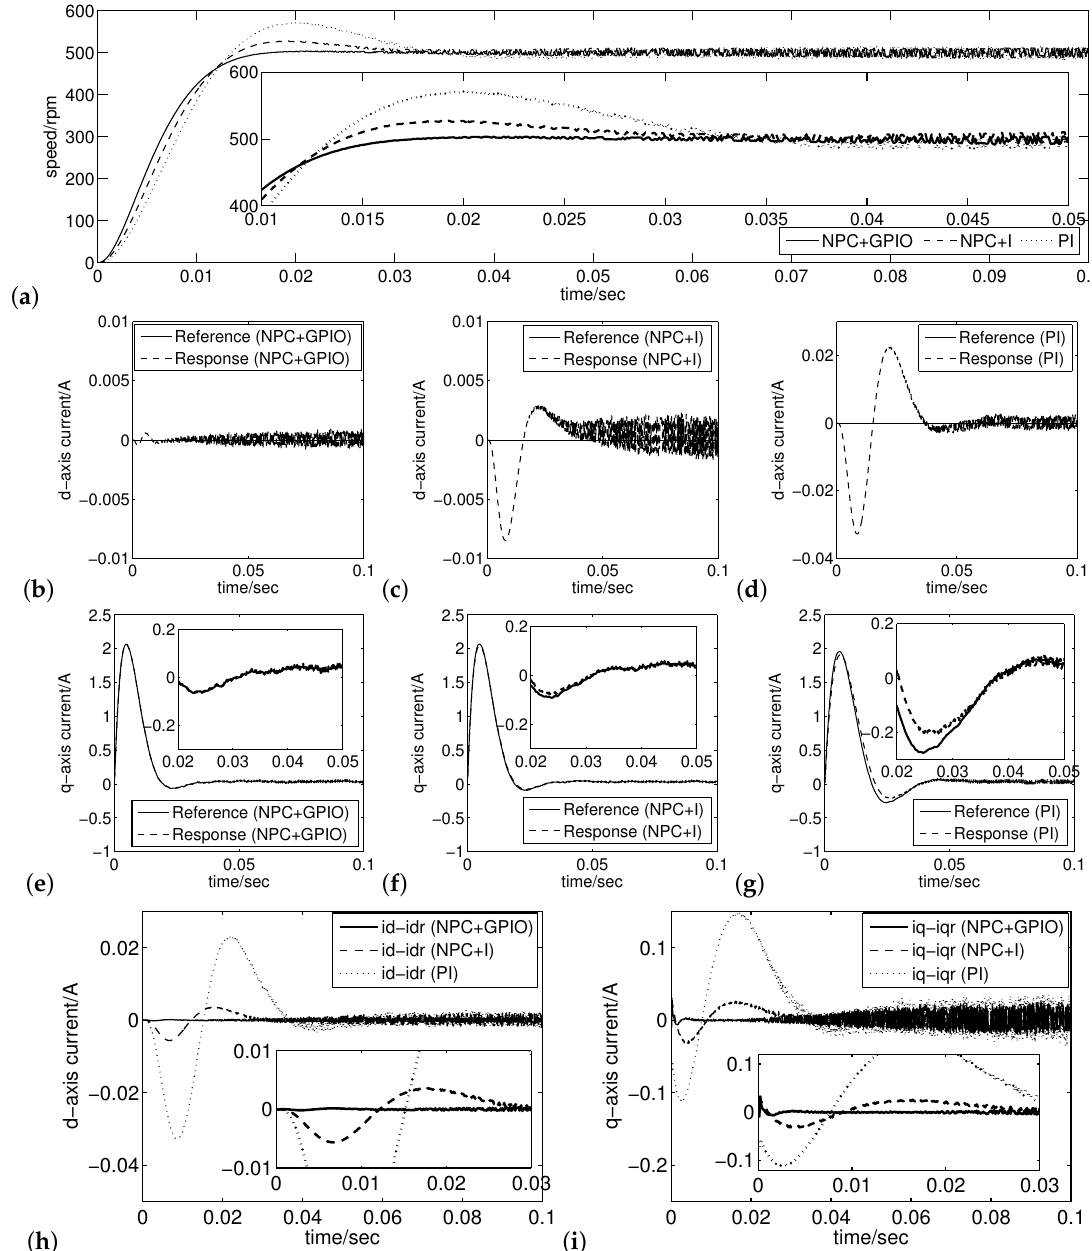
Figure 7. Speed and current responses with operation speed at 500 rpm under the same speed controller (PI) and the different current controllers (the proposed controller (NPC + GPIO), the integral controller (NPC + I) and the improved PI controller): ( a ) speed responses; ( b ) d-axis current response under the proposed controller; ( c ) d-axis current response under the integral controller; ( d ) d-axis current response under the PI controller; ( e ) q-axis current response under the proposed controller; ( f ) q-axis current response under the integral controller; ( g ) q-axis current response under the PI controller; ( h ) d-axis current-tracking errors under the different current-controllers (the d-axis response current (id) minus the d-axis reference current (idr)); ( i ) q-axis current-tracking errors under the different current controllers (the q-axis response current (iq) minus the q-axis reference current